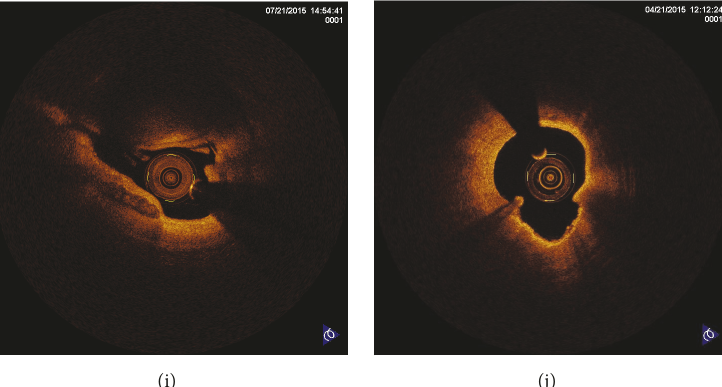
Figure 3: Representative optical coherence tomography (OCT) images of coronary atherosclerotic plaques with different characteristics. (a) Fibrotic plaque is characterized by a homogeneous OCT signal and high backscattering. (b) A fibroatheroma was characterized by an atherosclerotic plaque with an OCT-delineated necrotic core (formed by a signal-poor region with poorly delineated borders and little or no OCT backscattering), covered by a fibrous cap (signal-rich layer). (c) A calcific fibroatheroma was characterized by a plaque containing calciumdeposits (signal-poor regions with sharply delineatedborders). (d) A thin-capfibroatheromawas characterizedby a plaque with lipid content in ≥ 2 quadrants and with a fibrous cap < 65 𝜇 m. (e) Macrophage accumulation was reflected by a signal-rich punctate region in the background of an atheroscleroticplaque. Macrophages could be quantitatively classified as follows: grade 0, no macrophage; grade 1, localized macrophageaccumulation;grade 2, clusteredaccumulation < 1 quadrant; grade 3, clusteredaccumulation ≥ 1 quadrant but < 3 quadrants; and grade 4, clustered accumulation ≥ 3 quadrants. (f) Plaque rupture was characterized by discontinuity of the fibrous cap with a cavity formed inside the plaque. (g) Intracoronary thrombus was characterizedby a mass (diameter > 250 mm) that could be attachedto the luminal surface or floating within the lumen. A red thrombus that was rich in red blood cells could be identified by high backscattering and high attenuation, while a white thrombus that was rich in platelets could be identified by homogeneous backscattering with low attenuation. (h) The vasa vasorum was characterized by voids with poor signals that were sharply delineated in multiple contiguous frames. (i) Calcified nodules were characterizedby a small nodular calcification protruding from the lumen at the base of the fibrous calcified plaques with thrombus formation. (j) Acute Coronary Syndrome with Intact Fibrous Cap (ACS-IFC) was characterized by the following three conditions: (1) presence of the attached thrombus overlying an intact and visualized plaque; (2) irregularity of the luminal surface at the culprit lesion in the absence of thrombus; or (3) attenuation of the underlying plaque by thrombus that was not near a superficial lipid or